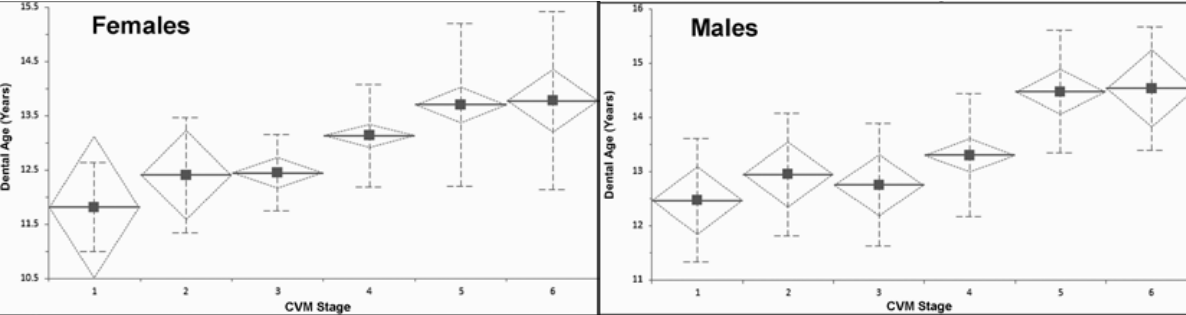
Figure 2. Mann Whitney U-test used to plot DA vs CVM stages for both females and males. There was no significant difference between consecutive stages. Height of dotted triangles – 95% CI, Dashed lines = 1